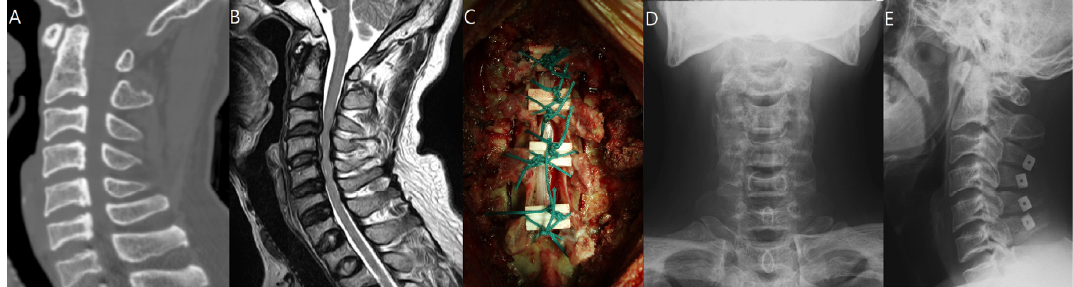
Figure 2. Pre-operative CT ( A ), pre-operative T2-weighted MRI ( B ), intra-operative photo ( C ), and post-operative AP ( D ) and lateral X-ray ( E ) of a 49-year-old male patient who underwent C3-6 midline splitting double-door type (French door type)